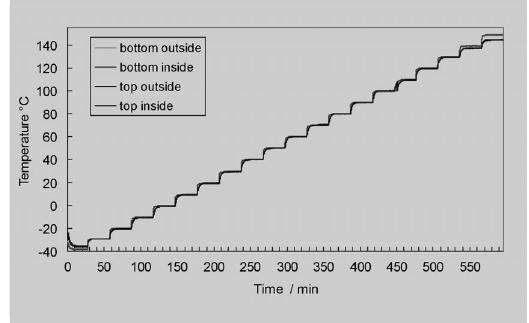
Figure 5 (left): Temperature gradients for the Advanced Peltier System PTD 150. Virtually no significant gradients are existing across the sample in the temperature range from – 30°C to + 130°C. Figure 6 (right): Temperature gradients with the 50 mm sensor tool for the Advanced Peltier System PTD